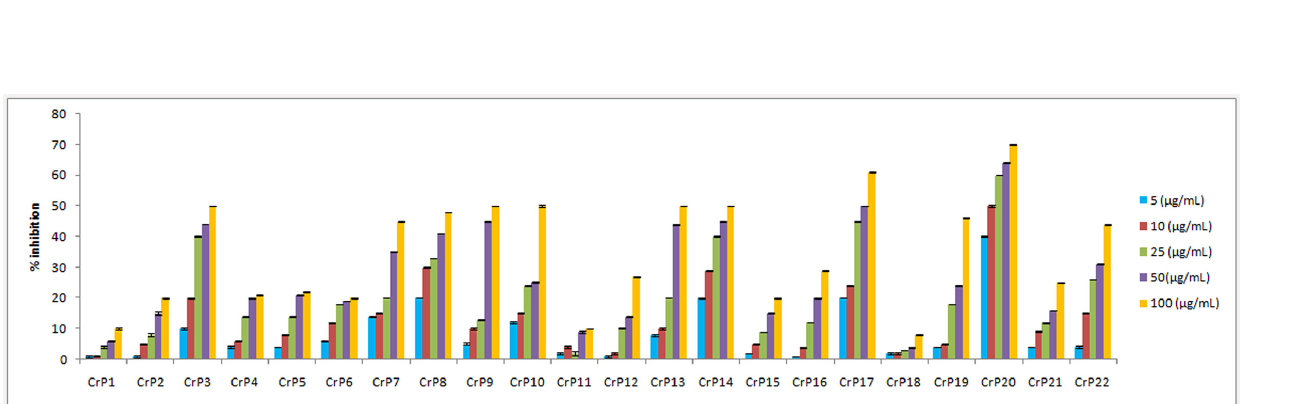
Fig 3. Effects of the ethyl acetate extracts of mycelium on the antiproliferative activity of HeLa